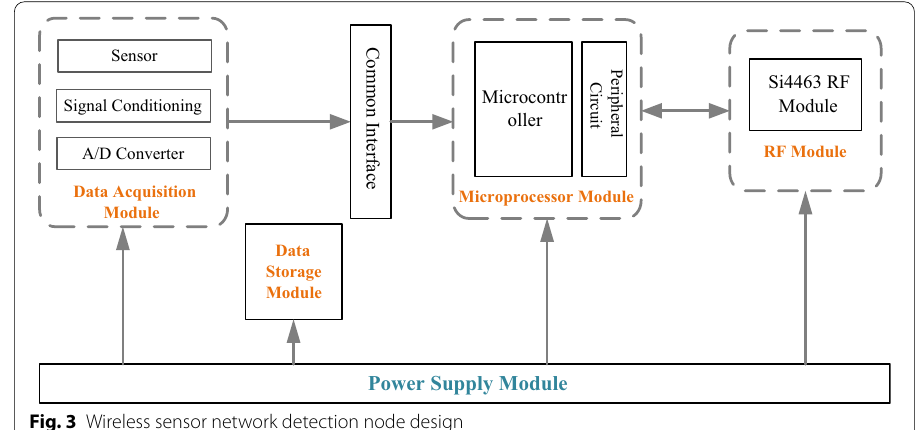
Fig. 3 Wireless sensor network detection node design